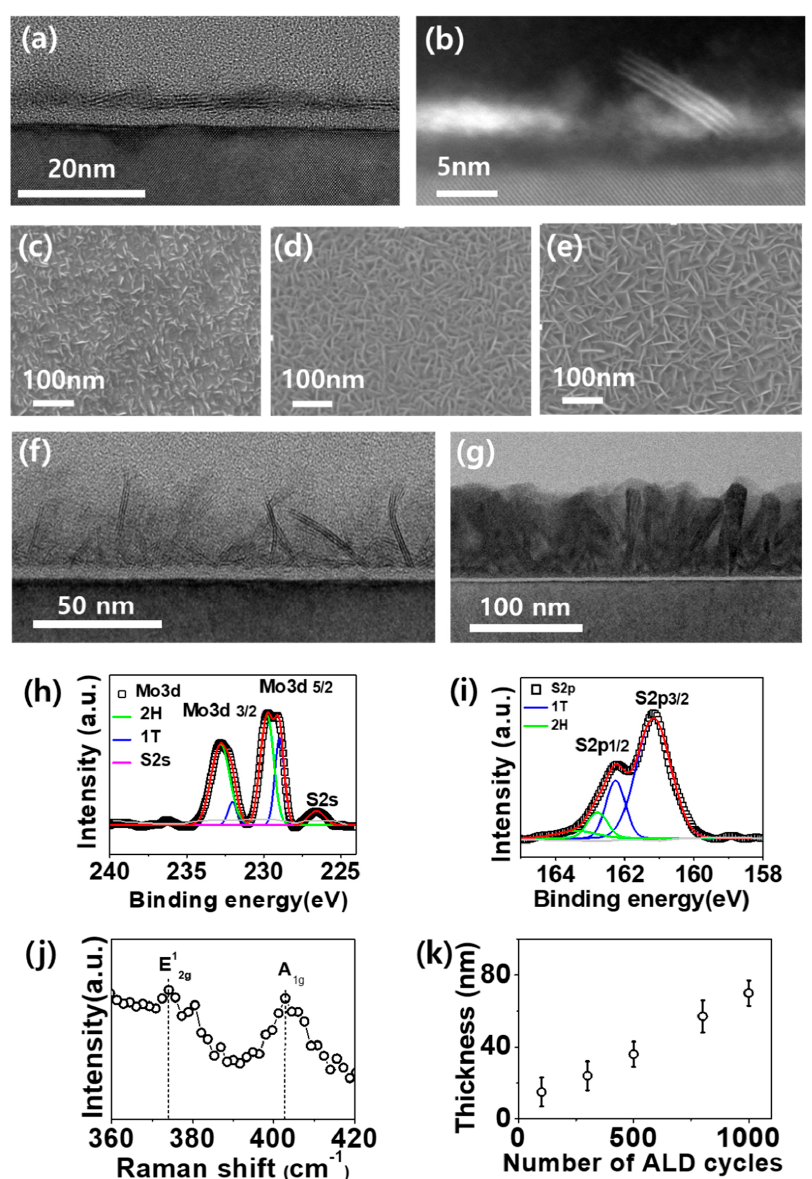
Figure 2. Preparation of p -Si/SiO x /MoS 2 photocathodes via ALD as a function of deposition cycles. ( a – g ) Electron micrographs of MoS 2 of different thicknesses on Si: ( a ) Cross-sectional TEM and ( b ) STEM images of 100 ALD-cycled MoS 2 on Si; ( c ) SEM of 300 cycles; ( d ) SEM of 500 cycles; ( e ) SEM of 1000 cycles; ( f ) TEM of 300 cycles; ( g ) TEM of 1000 cycles showing a few layers of the MoS 2 stacked together. ( h , i ) High-resolution XPS spectra of Mo 3d and ( k ) S 2p core level peaks, and ( j ) Raman spectra of MoS 2 on Si. ( k ) Thickness as a function of ALD cycles, showing the linear growth